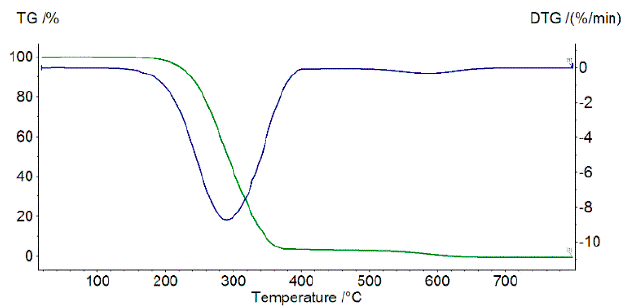
Figure 2. TG (green) and DTG (blue) curves of ligand decomposition in air.